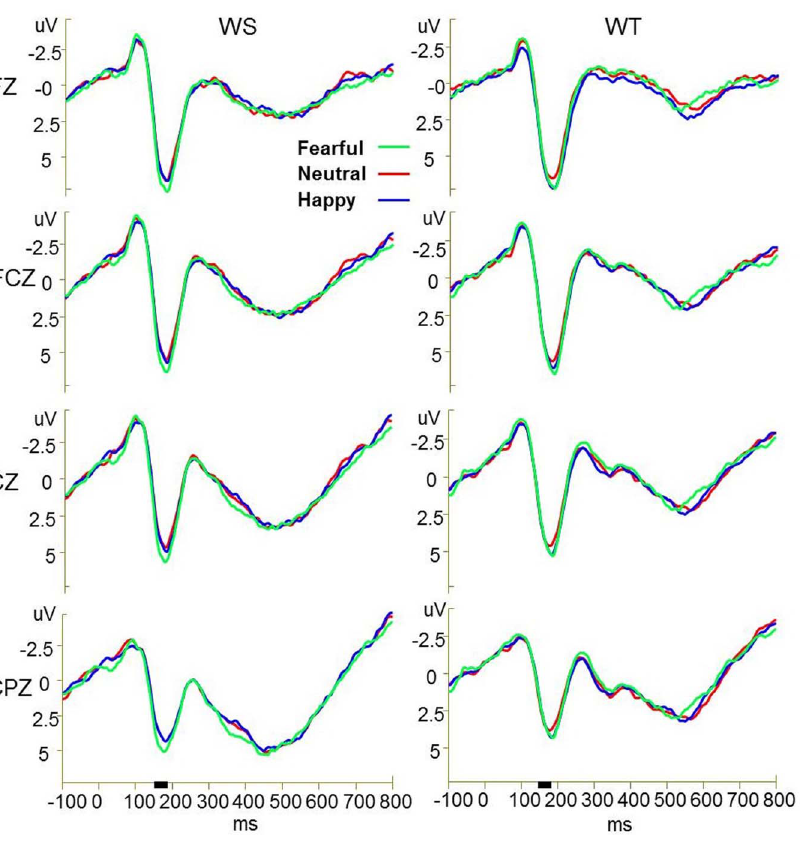
Figure 2. Grand-average ERPs by six conditions at FZ, FCZ, CZ, CPZ electrodes. Grand-averaged event-related potential waveforms elicited by fearful, neutral, and happy faces respectively during performance of word structure tasks (WS) and word tone tasks (WT) at FZ, FCZ, CZ, CPZ electrode.